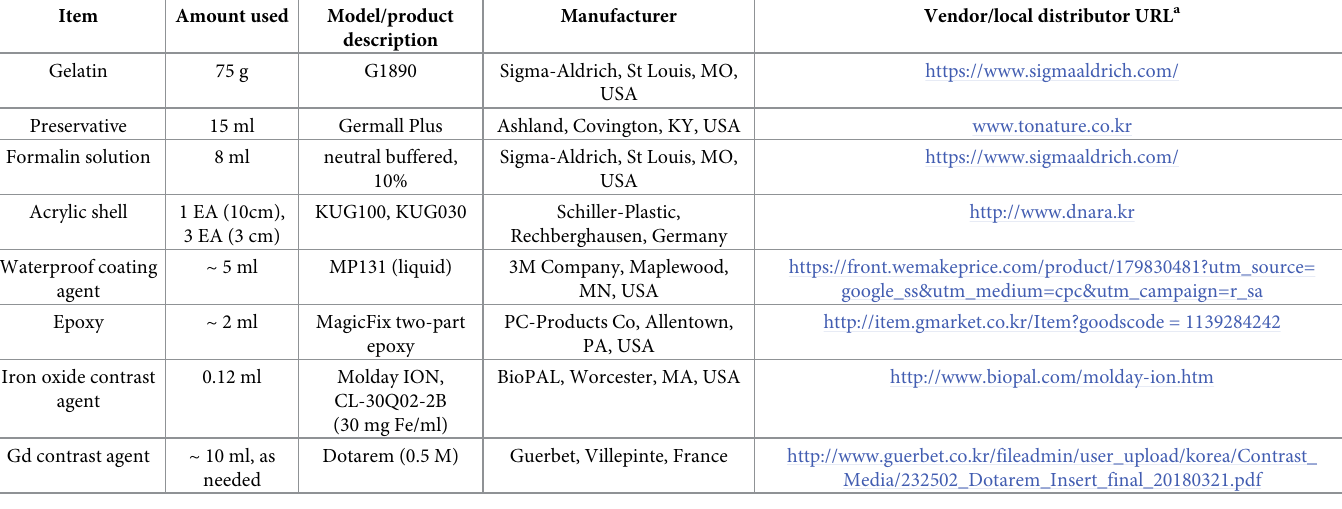
Table 1. Materials used for the fabrication of a 10 cm-diameter gelatin sphere phantom with three inclusions.